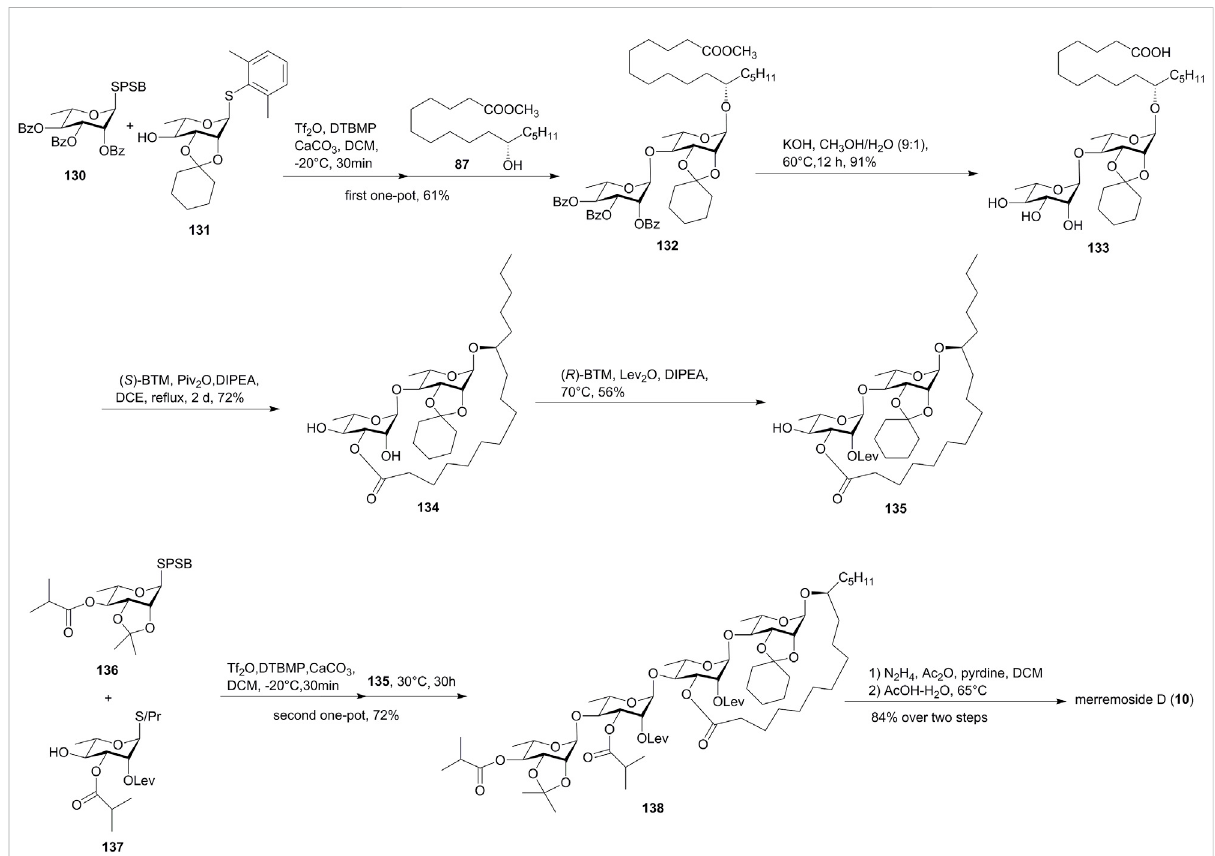
FIGURE 11 Wan ’ s approach toward the synthesis of merremoside D ( 10 ). SPSB, S -2-[(propan-2-yl)sul fi nyl] benzyl; BTM, benzotetramisole; DIPEA, N, N-diisopropylethylamine; Lev: